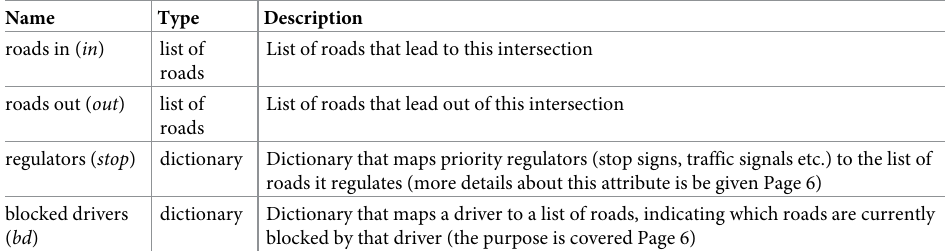
Table 2. Attributes of the intersection